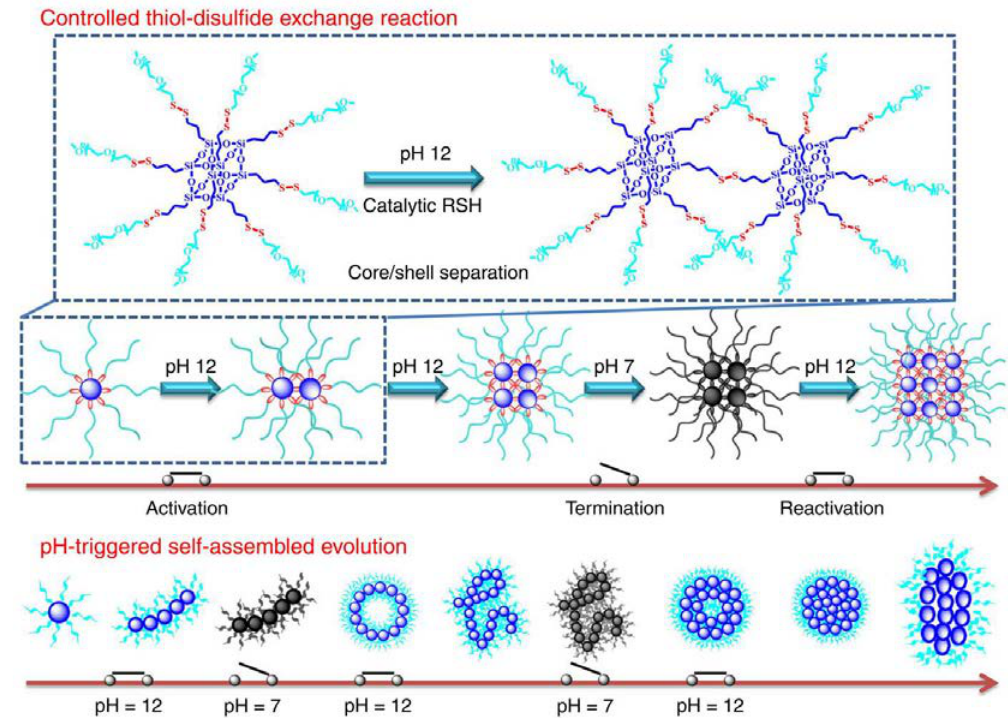
Figure 2. Controllable morphology evolution of the copolymers with a pH-switched on/off function. When the thiol–disulfide exchange reaction is activated in the presence of catalytic thiols in pH 12 solutions, the selective core/shell separation gradually leads to the continuous connections of POSS-embedded cores. Then, the self-assembled evolution is performed from unimolecular micelles to form the elliptic nanoparticles. Reprinted with permission from [93]. Copyright (2018) Creative Commons Attribution 4.0 International License.